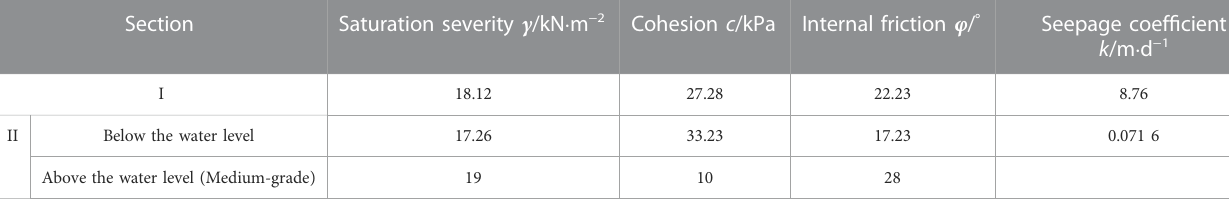
TABLE 2 Weighted value of stratum property parameters.